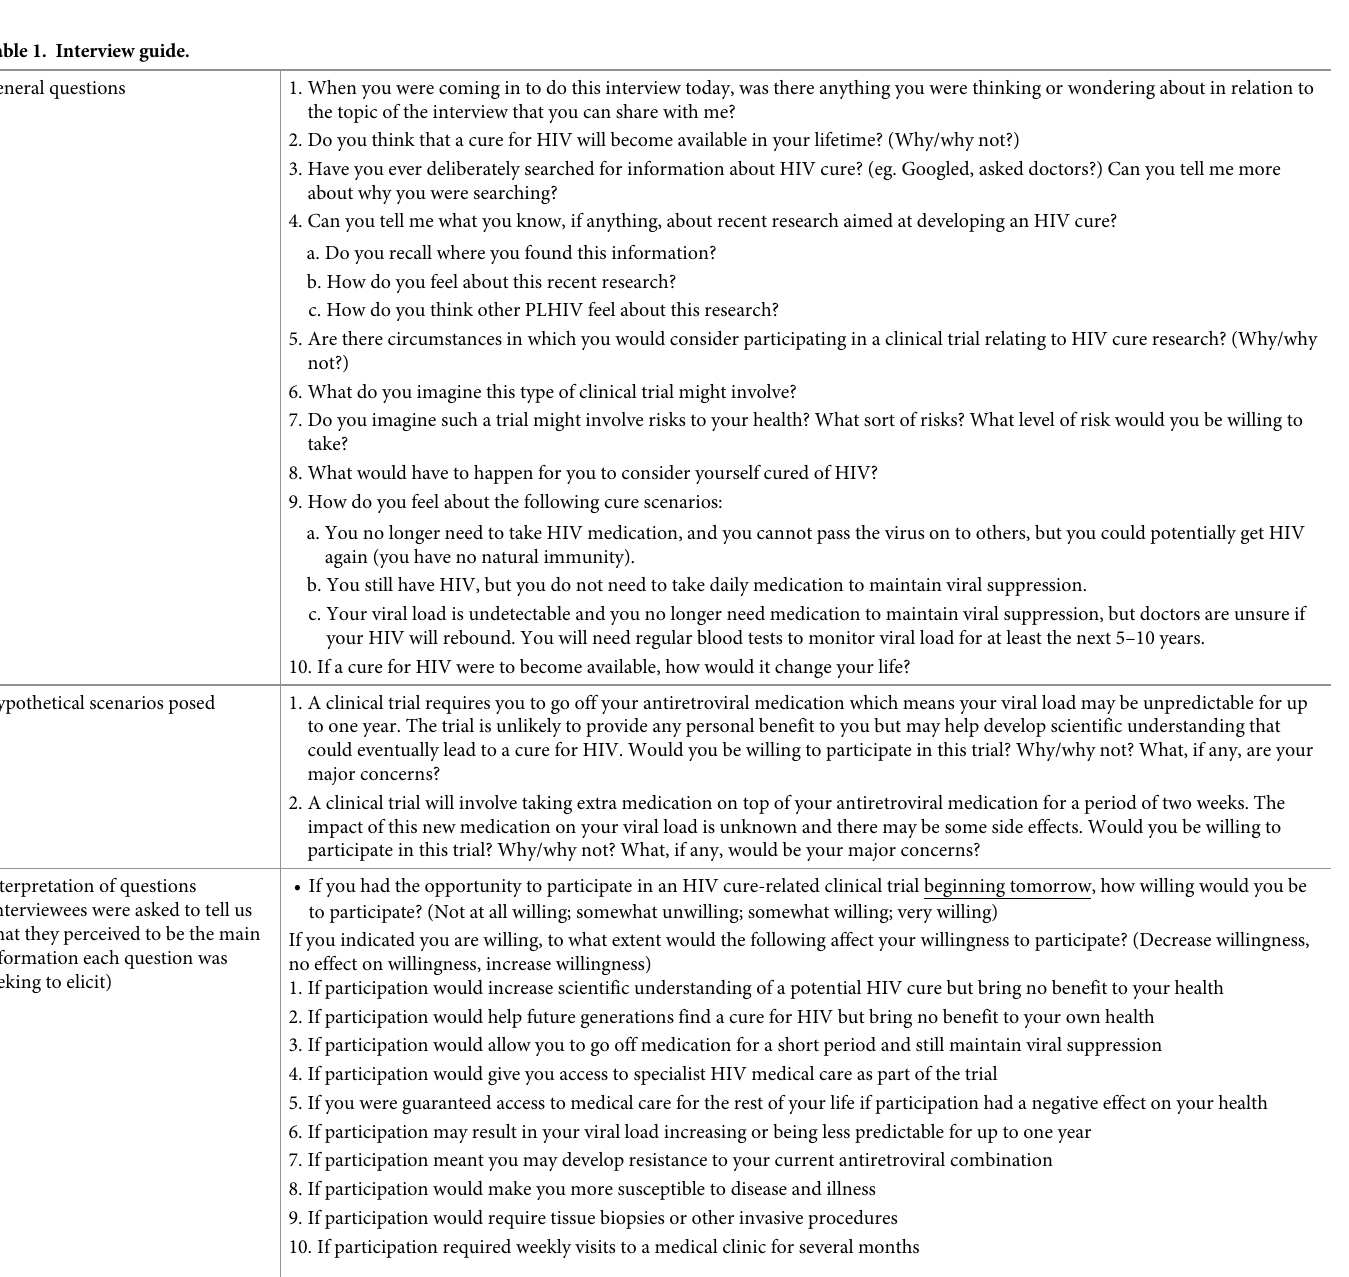
Table 1. Interview